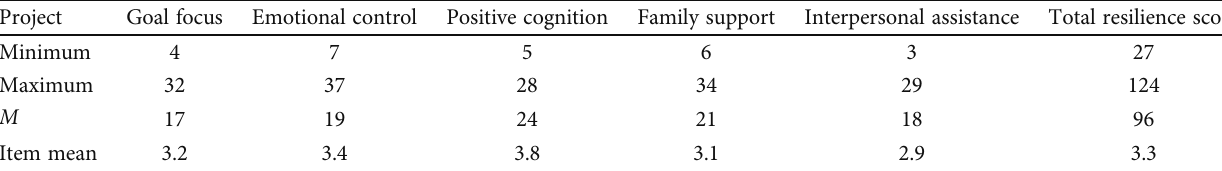
Table 2: Overall situation of psychological